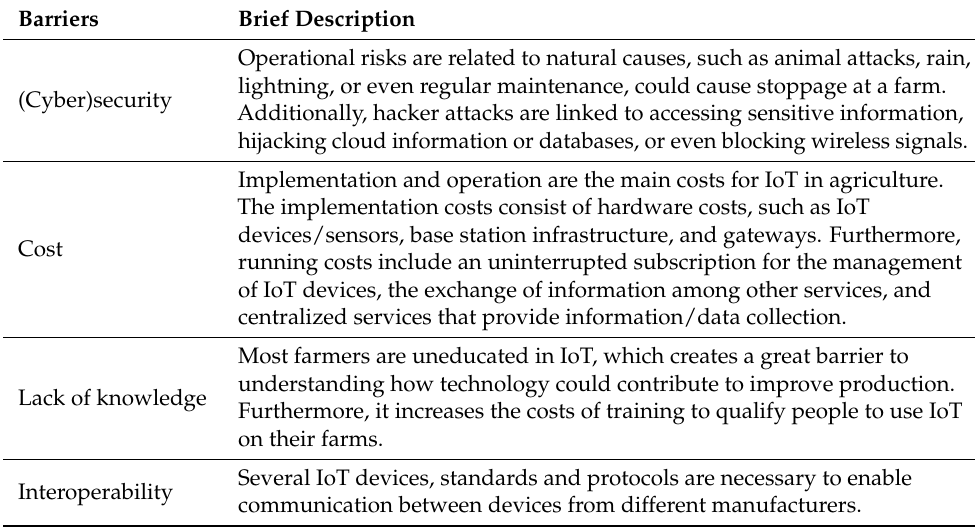
Table 4. Brief description of main IoT challenges (adapted from